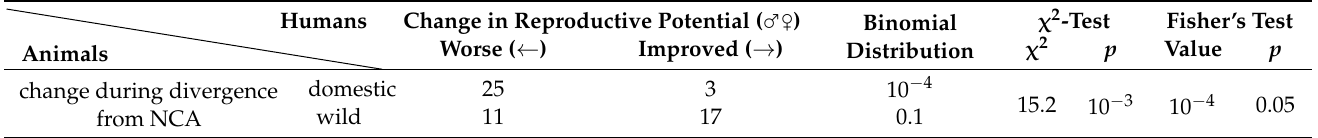
Table 6. Correlations between the effects of the co-directed changes in the expression of orthologous genes on human reproductive potential and on the divergence of domestic and wild animals from their